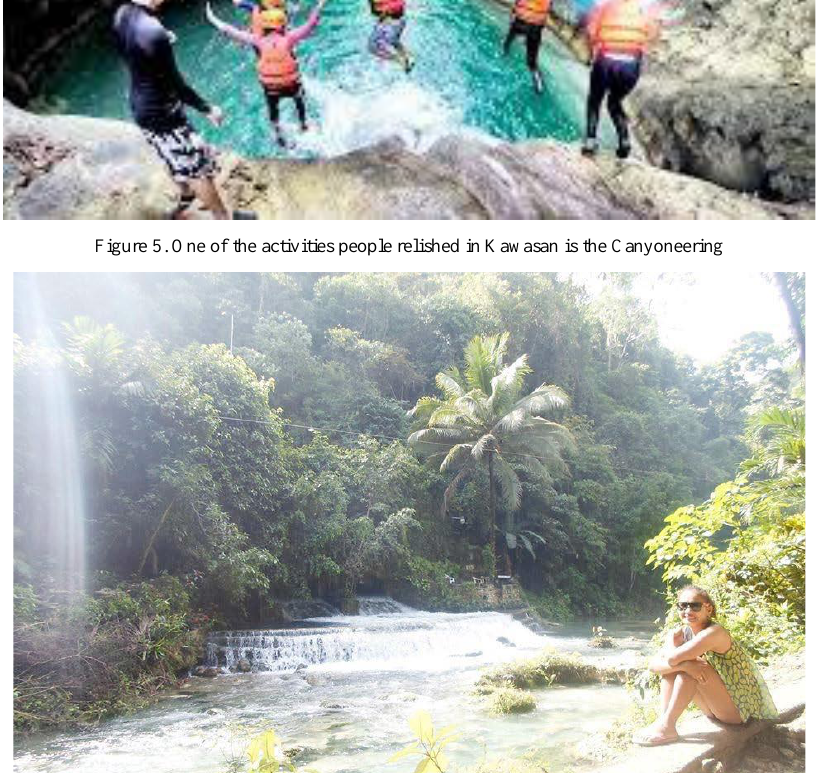
Figure 6. Kawasan is surrounded by preserved forest